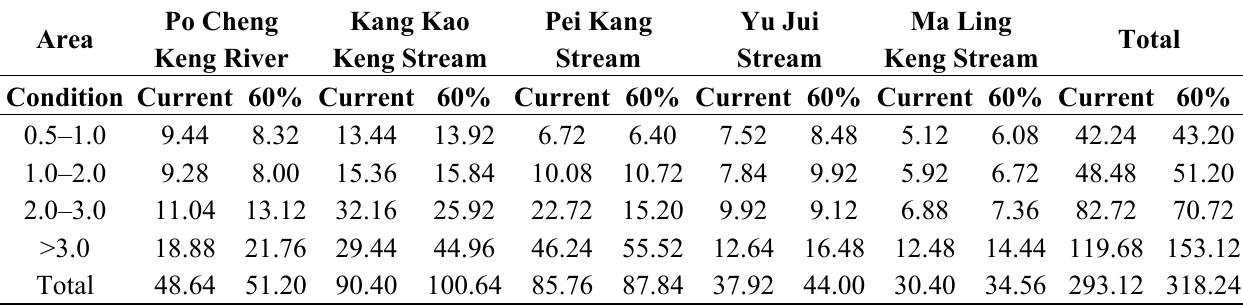
Table 6. The entire area’s inundation area at different levels of development for the 200-year return